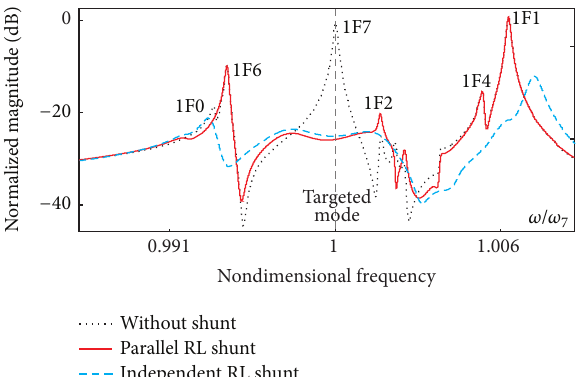
Figure 10: Simulation. Normalized FRF 𝑇(𝜔) = | ̇𝑥/𝜂| between the forcing function and the velocity of the tip of one blade in the vicinity of 𝜔 7 ; effect of the RL shunt tuned on mode 1F7 with both configurations: independent and parallel